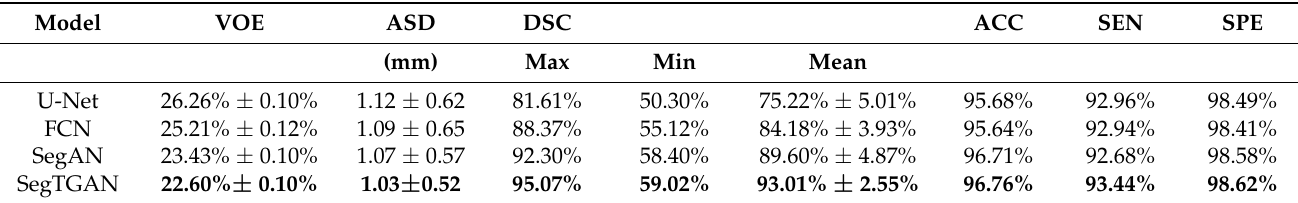
Table 3. Comparison of U-Net, FCN, SegAN, and SegTGAN on the Kits21 dataset.